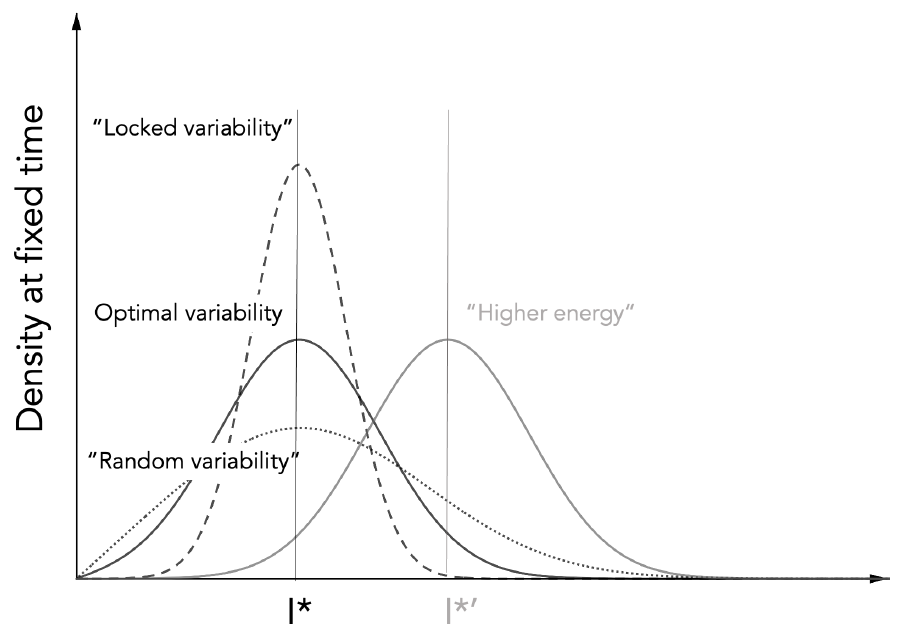
Figure 4. Schematic representation of several types of adiabatic invariant densities. Here is assumed that the black solid line is the density of a young, healthy, individual. The maximally probable adiabatic invariant in this case is denoted I ∗ . The “locked” (dashed line) and “random” (dotted line) curves correspond to, respectively, smaller and higher diffusion coefficients than the optimal one. The “higher energy” curve (grey solid line) has an optimal diffusion coefficient, but a higher maximally probable adiabatic invariant, denoted I ∗